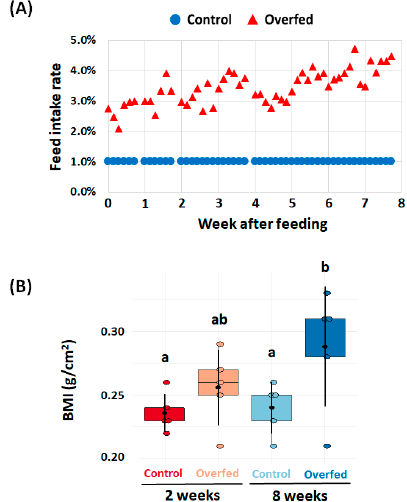
Figure 1. ( A ) Daily feed intake rate for 8 weeks in the control (1% bodyweight of dry commercial feed) and overfed groups. ( B ) BMI of the control and overfed trout at weeks 2 and 8. The feed intake ratio was calculated by dividing the feed weight by the bodyweight. Different letters indicate statistically significant differences determined by Duncan’s multiple range test ( p < 0.05).